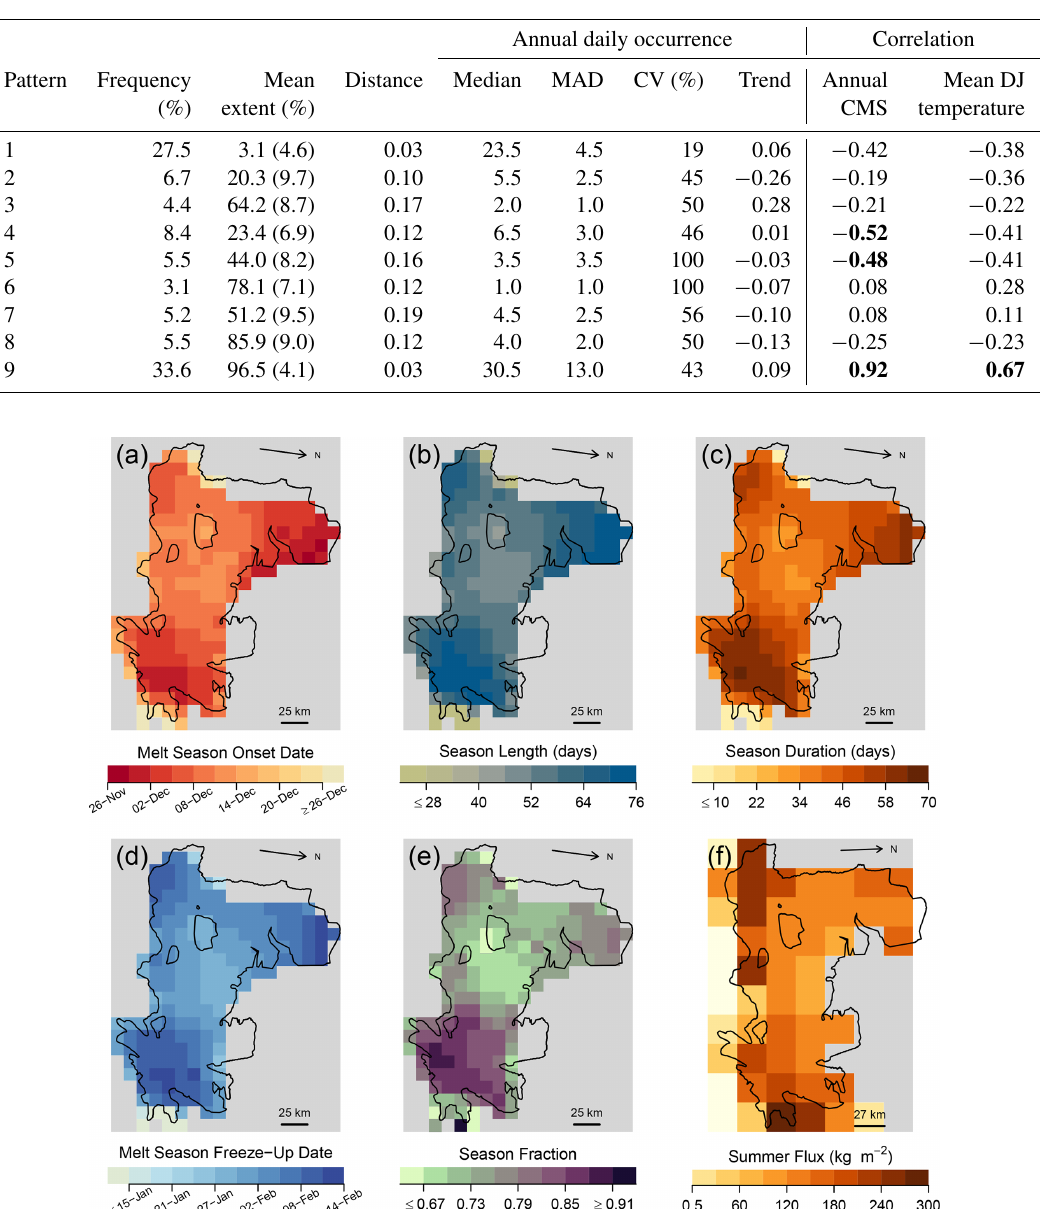
Table 1. Summary statistics for the nine representative melt patterns. Frequency is the percentage of all melt season days on which the pattern occurs across all 18 summers. Mean extent is the average shelf area that melts for a pattern, with the standard deviation shown in brackets. Distance refers to the average Tanimoto distance between the SOM pattern and the observed melt distributions it represents. The coefficient of variation (CV) is defined as the median absolute deviation (MAD) divided by the median of the annual pattern counts (Liu et al., 2006). Trends are calculated with a Mann–Kendall linear trend test; no values are statistically significant. Bold values indicate correlations significant at p < 0 . 05. Summer temperatures are from RACMO2.3p3 for the area depicted in Fig. 7b. The cumulative melting surface (CMS) is defined as explained in Sect. 2.5.